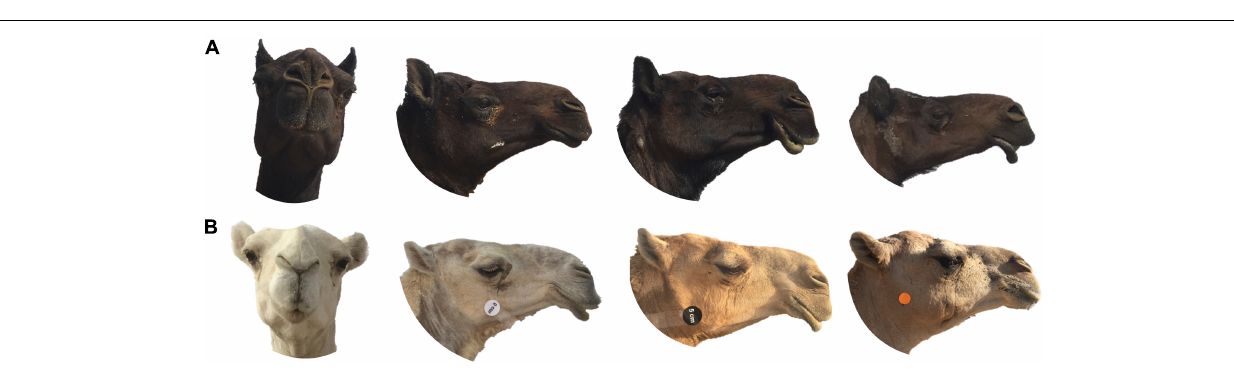
basic information for each camel sample. The majority of the sampled camels in the Cdrom Archive have been